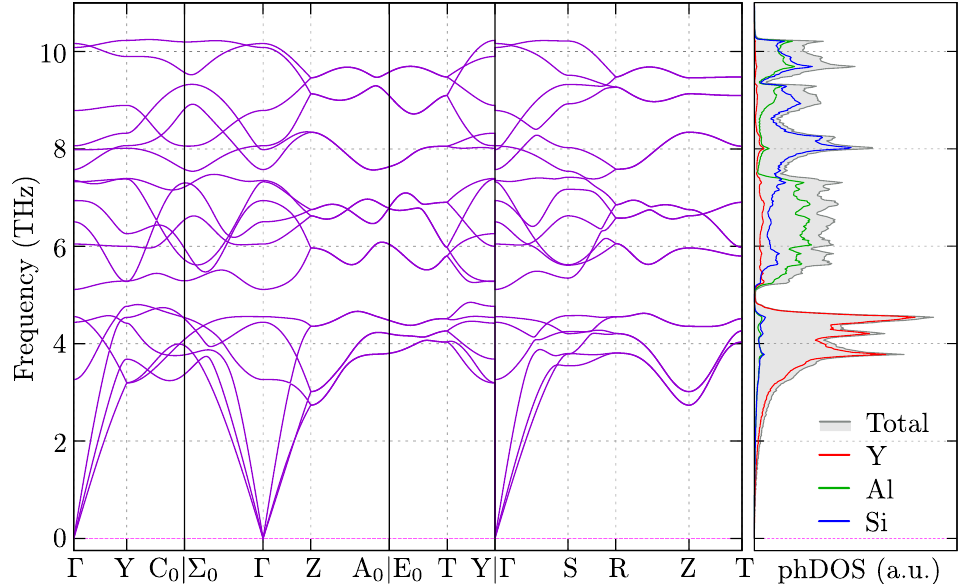
Figure 3. Phonon dispersion and the density of states for YAlSi with Cmcm